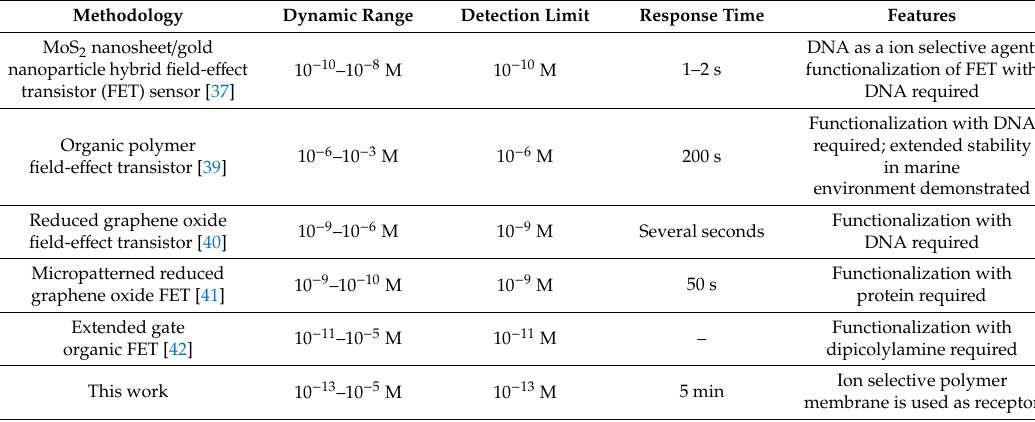
Table 2. Comparison of contemporary FET based mercury